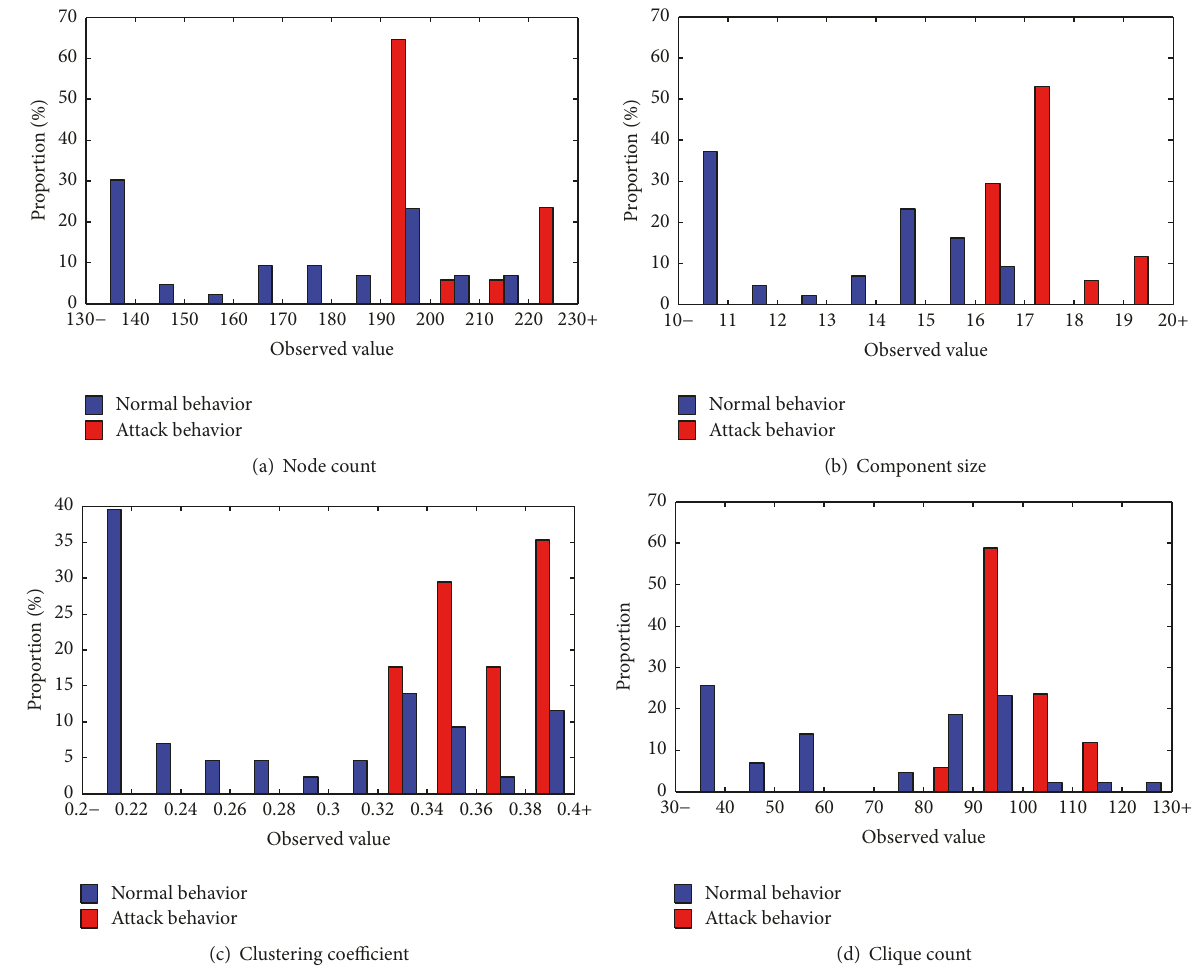
Figure 5: Distributions of the select measures of Al-Qaeda